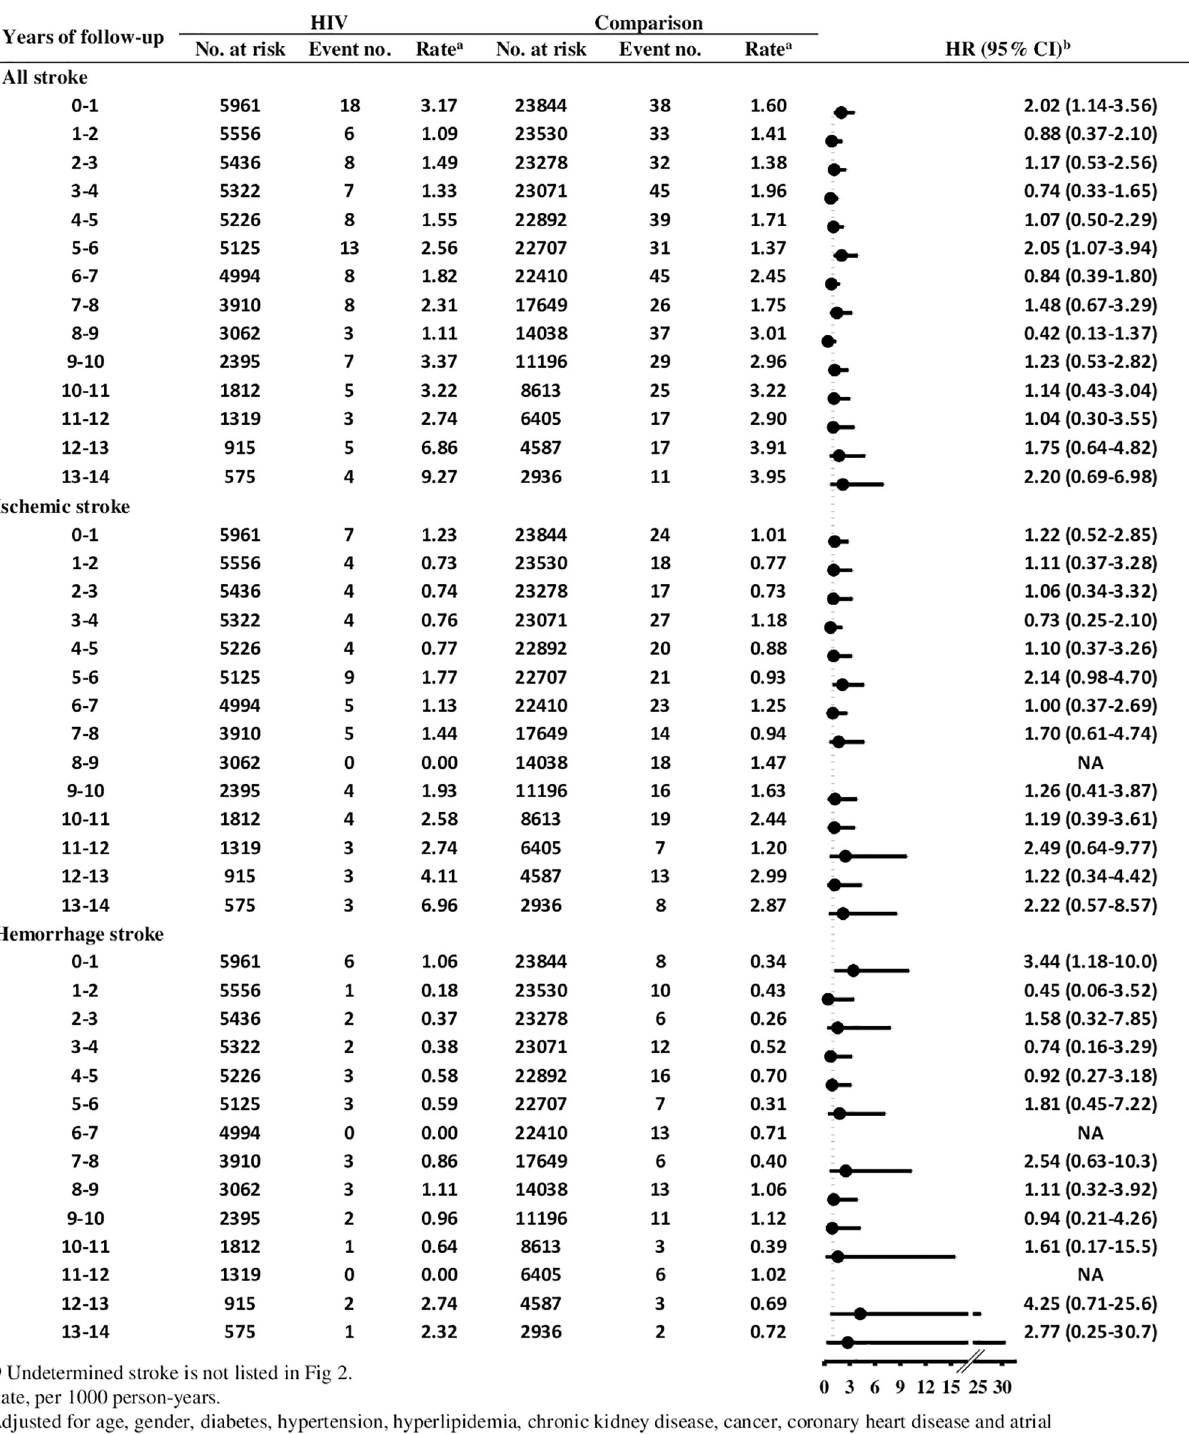
PLOS ONE | https://doi.org/10.1371/journal.pone.0217147 May 22,